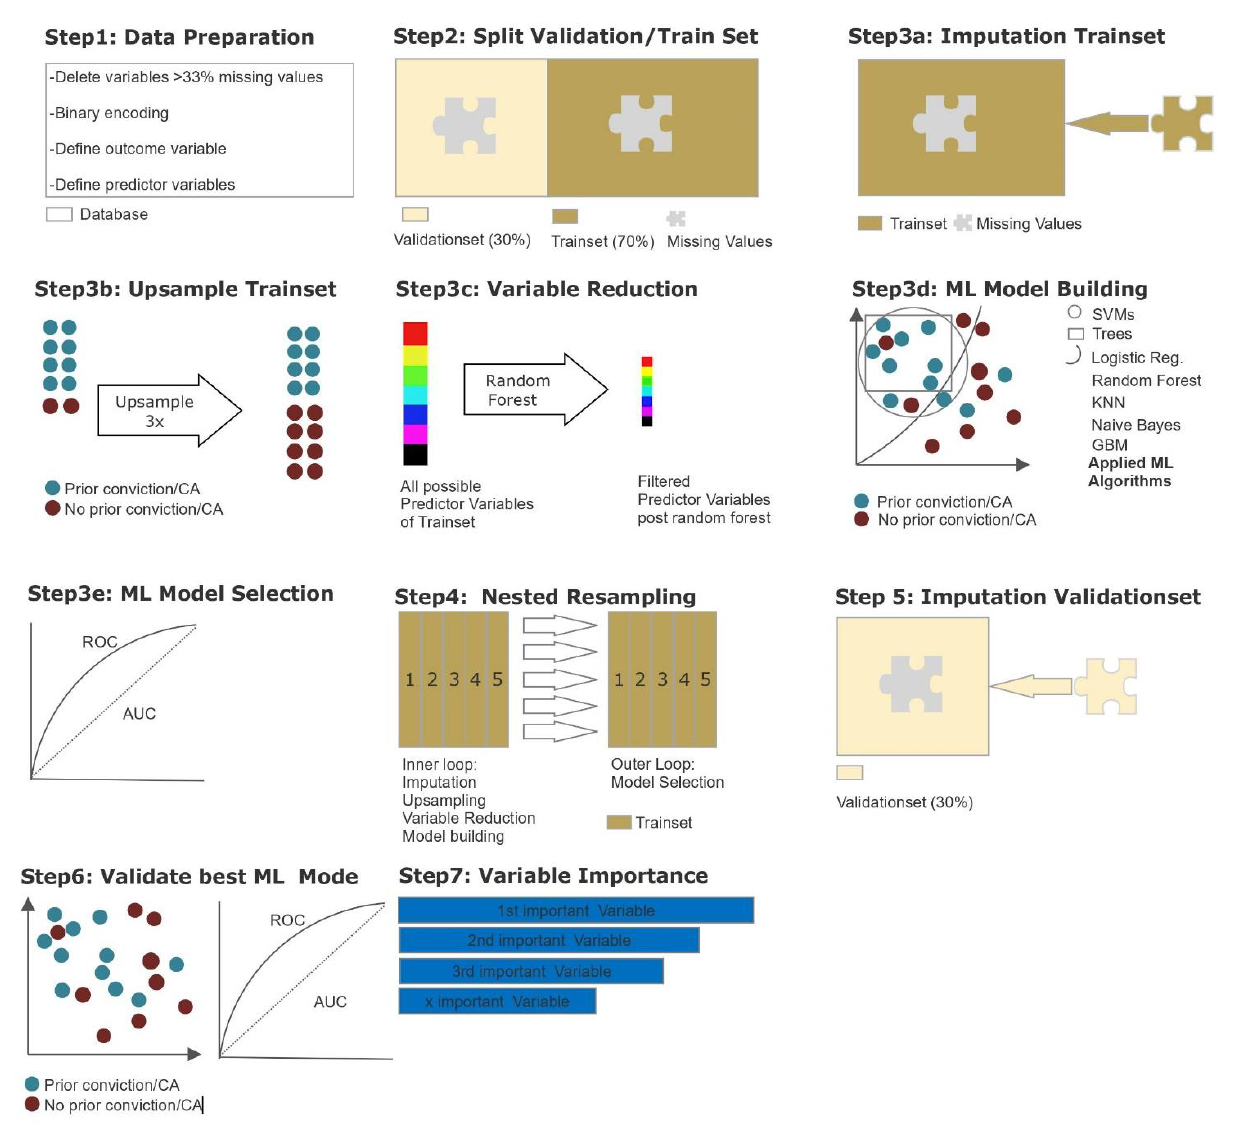
Figure 1. Statistical procedures using machine learning.